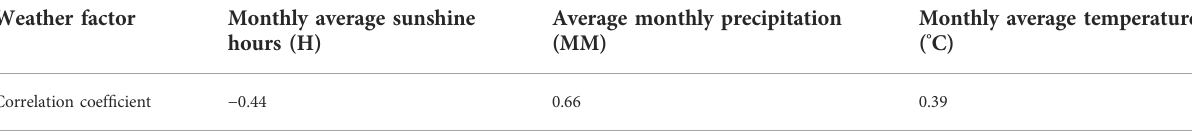
TABLE 2 Correlation between YLR and meteorological factors throughout the growth